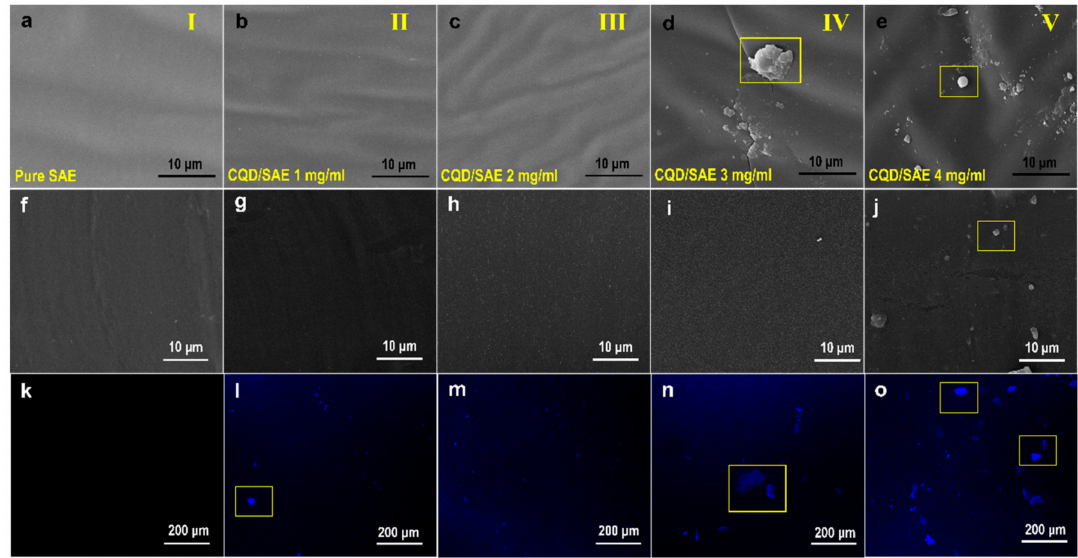
Figure 4. Images of SAE coating films containing various contents of CQDs. ( a – e ) SEM images of coating films. ( f – j ) Sectional SEM images of coating films. ( k – o ) CLSM images of coating